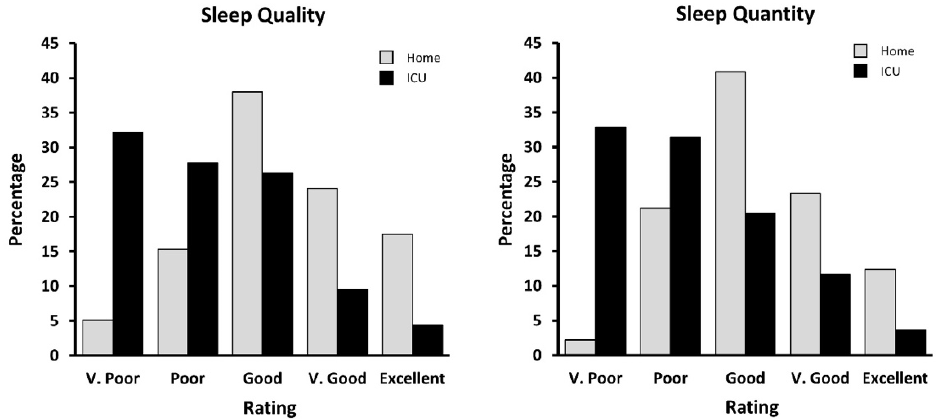
Figure 1. Self-reported sleep quality ( left ) and quantity ( right ) at home (grey) and while in the ICU (black). Table 1. Self-reported factors that led to poor sleep in the